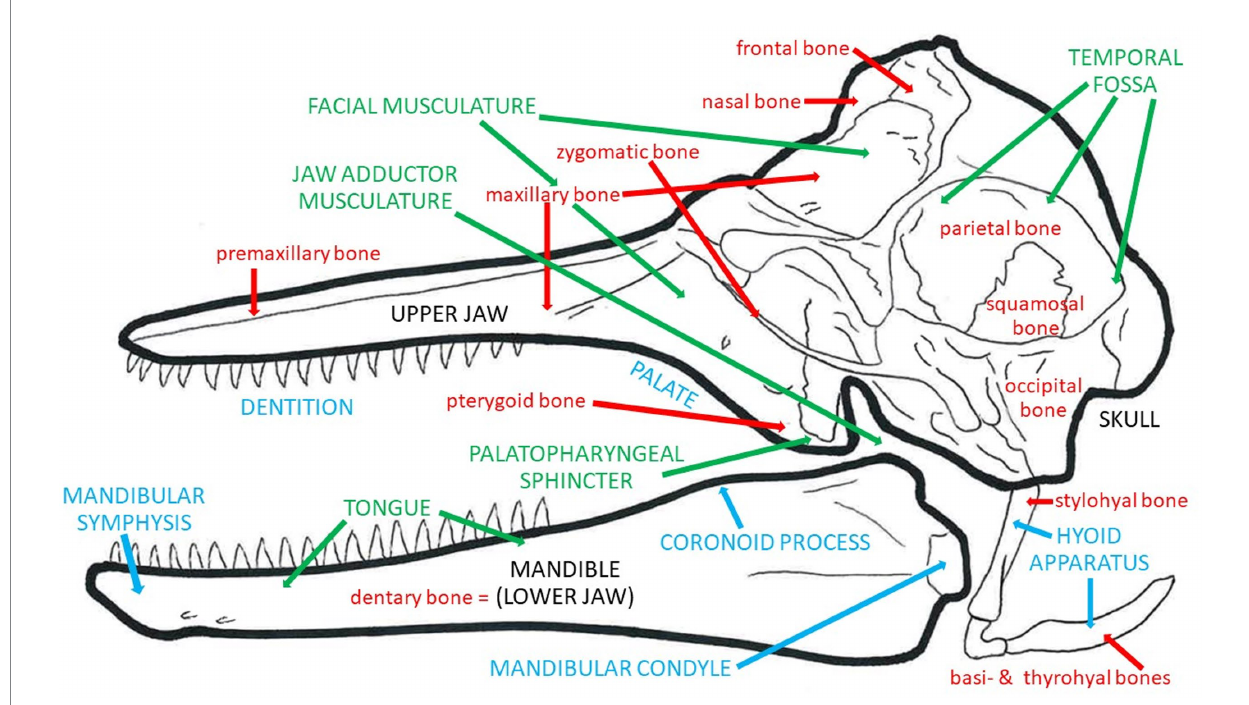
FIGURE 7 Summary of osteological correlates of feeding in a Recent odontocete, showing individual bones in red, muscle groups and other soft tissues in green, and bony features, landmarks, and complexes in blue.